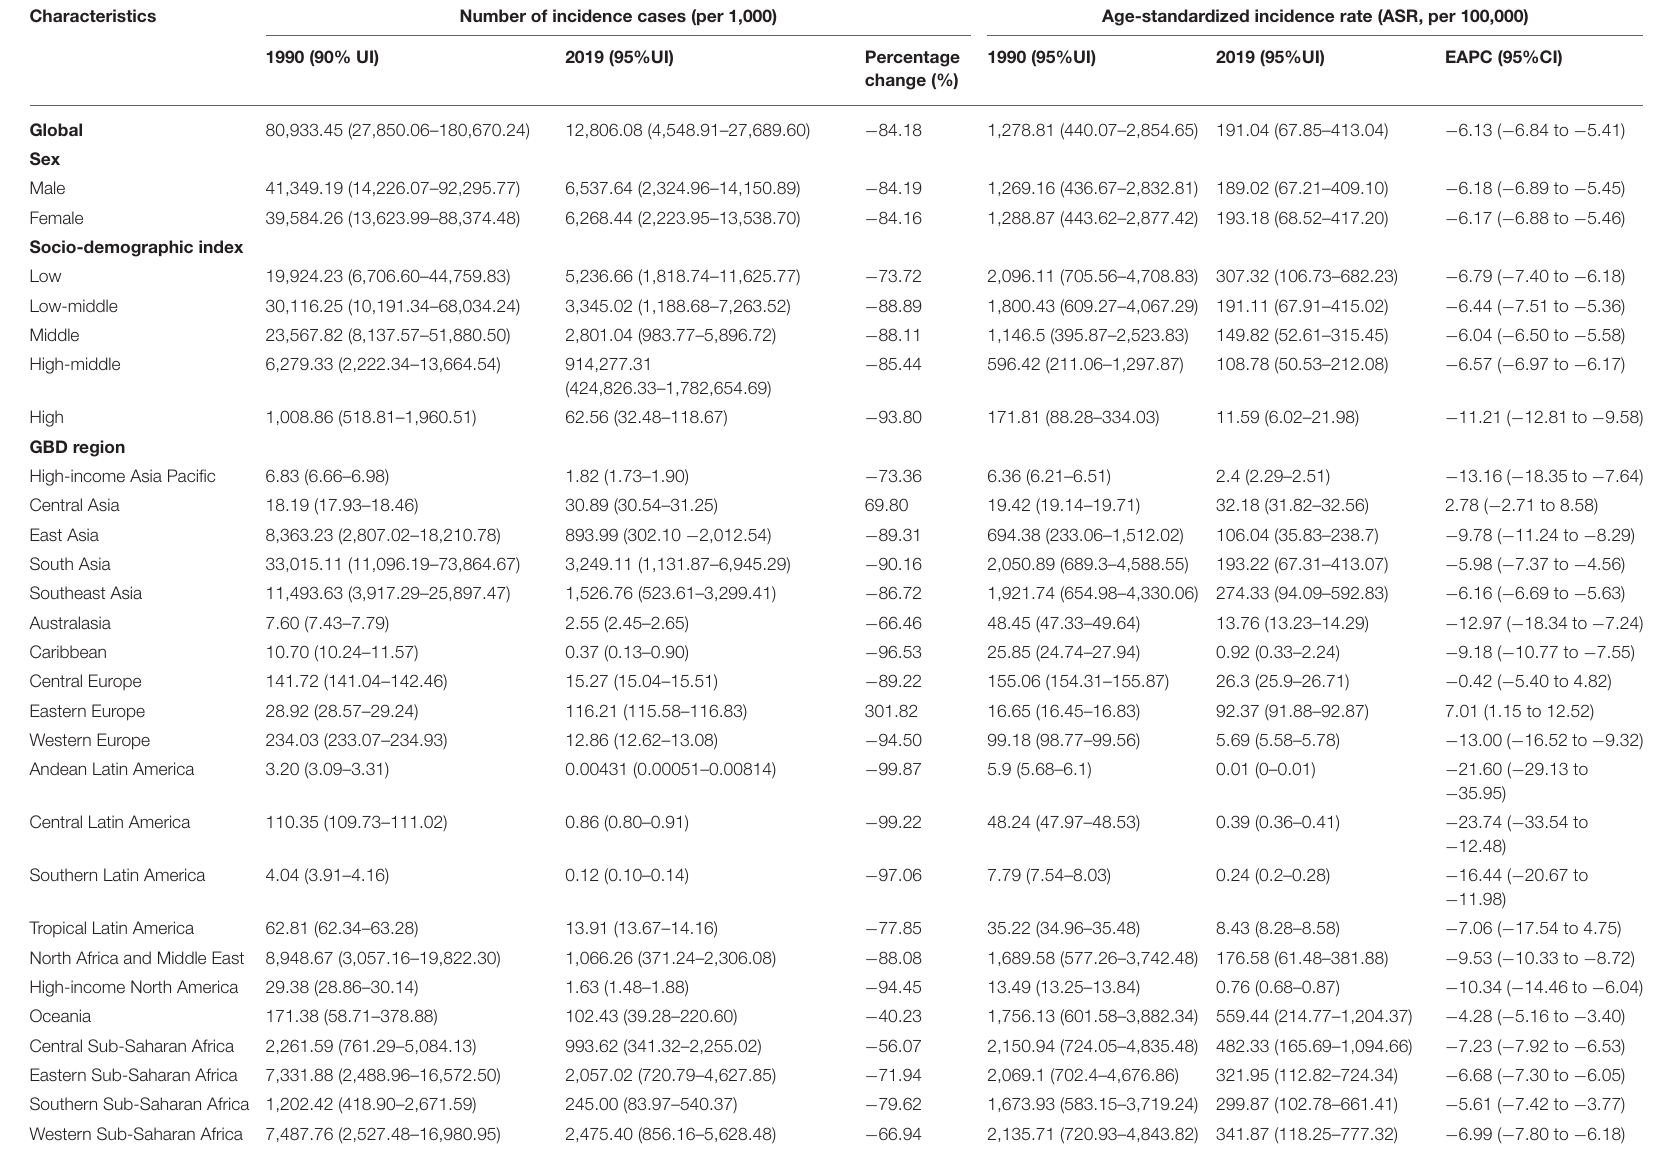
TABLE 1 | The number of incidence cases and age-standardized incidence rates (ASR, per 100,000) of measles in 1990 and 2019, and their temporal trends from 1990 to 2019.